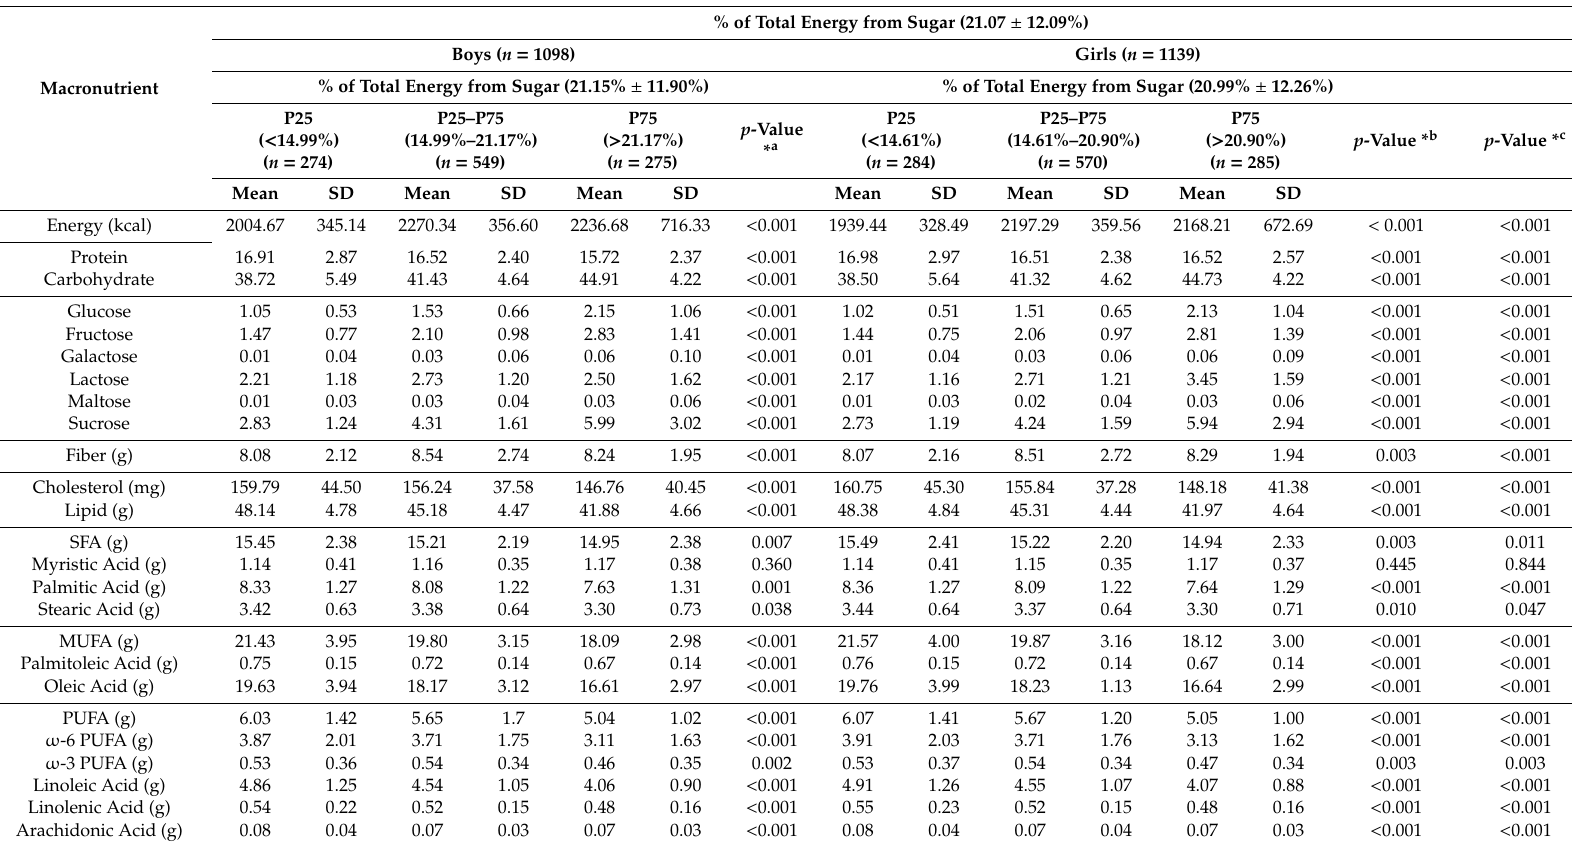
Table 9. Macronutrients intake consumed by percentage of total energy derived from total sugar intake by 6–8 years old children ( n = 2237) in Valencia, Spain,